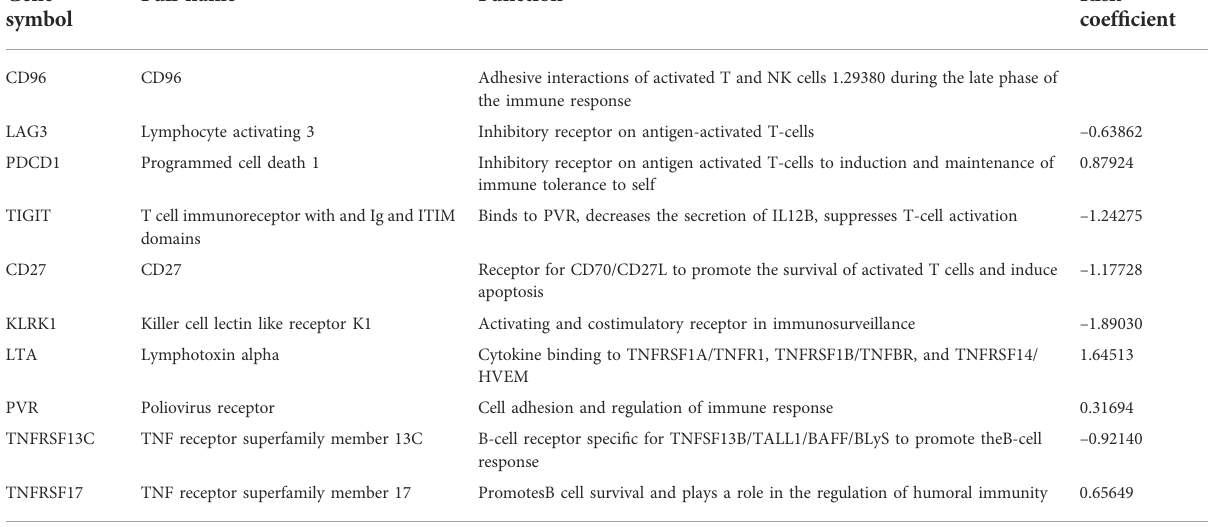
TABLE 2 Function and risk coef fi cients of the genes involved in the prognostic signature.